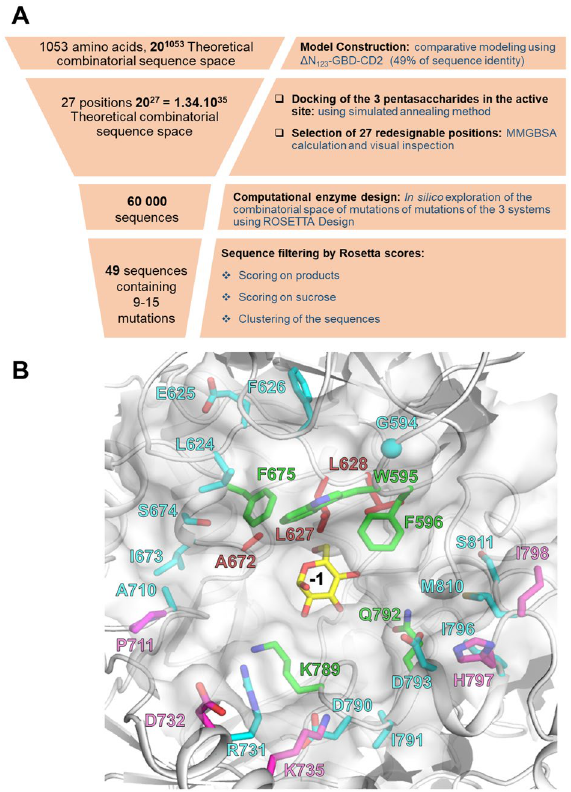
Figure 2. ( A ) Computer-aided approach for BRS-B Δ2 active site re-design. After successive steps, the final designed library contained 49 sequences featuring between 9 and 15 mutations in the active site, each. ( B ) View of the active site of BRS-B Δ2 model. The 27 redesignable amino acids are shown in red, green, cyan and magenta according to their belonging to the first, second, third and fourth contact shell, respectively, surrounding the glucosyl residue (yellow sticks) in the -1 position as extracted from the structure of inactive GTF-180 in complex with sucrose (PDB ID: 3HZ3). The docked pentasaccharides are not shown for